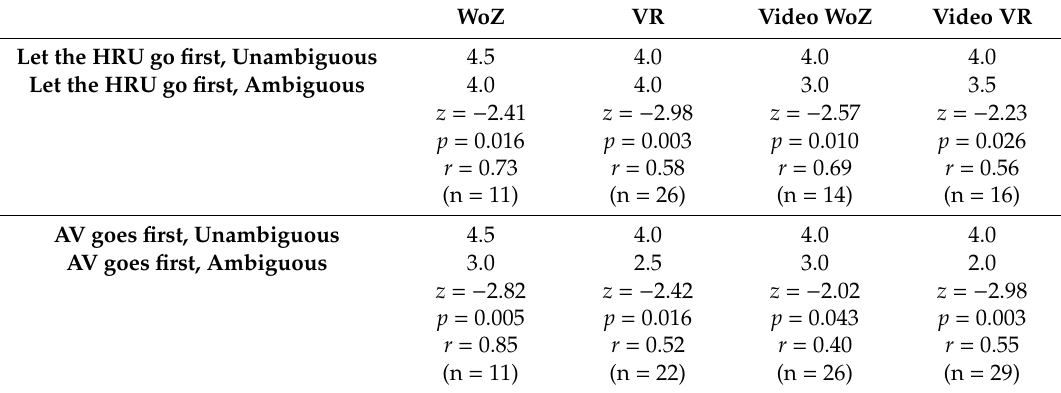
Table 12. Median ( Mdn ) of the perceived criticality (1 = very critical, 5 = very uncritical), segregated by setup.